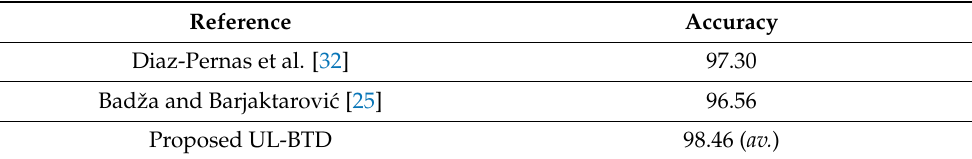
Table 10. Comparison of SVM and CNN in terms of complexity for 613 test images (20% of the dataset).